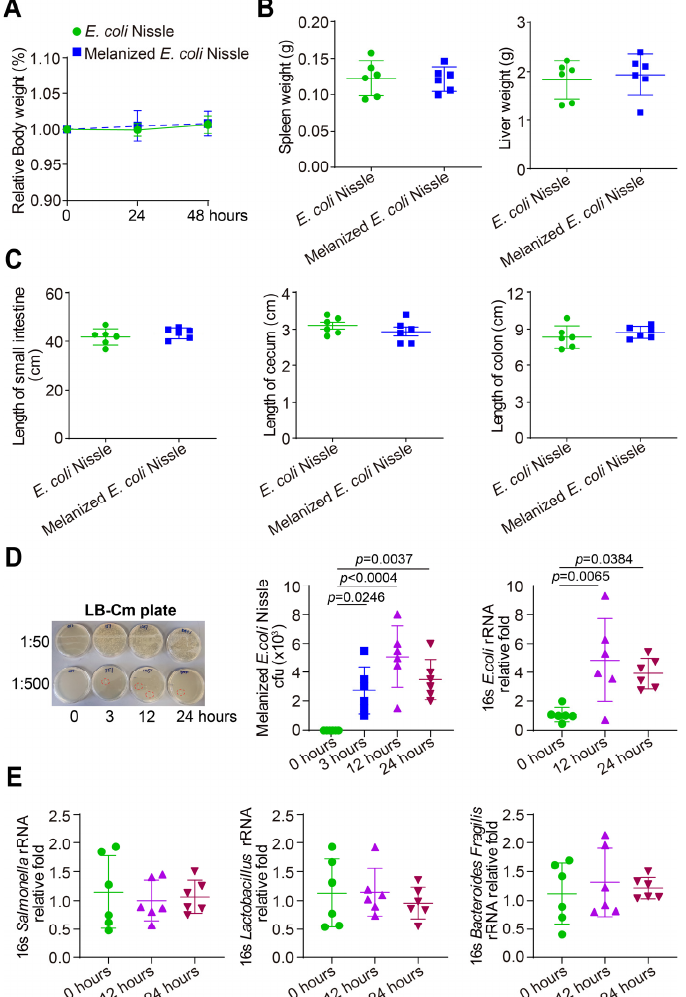
Figure 2. CD-1 mice were one-gavaged with probiotic E. coli Nissle or melanized E. coli Nissle. ( A ) Relative body weight did not change in CD-1 mice gavaged with probiotic E. coli Nissle or melanized E. coli Nissle. Data are expressed as mean ± SD. N = 6, two-way ANOVA test and the p -values were adjusted with Tukey method for multiple comparisons. ( B ) The spleen and liver weight did not change significantly in CD-1 mice gavaged with probiotic E. coli Nissle or melanized E. coli Nissle post 48 h. Data are expressed as mean ± SD. N = 6, Welch’s t test. ( C ) The length of small intestine, cecum and colon did not change in CD-1 mice gavaged with probiotic E. coli Nissle or melanized E. coli Nissle post 48 h. Data are expressed as mean ± SD. N = 6, Welch’s t test. ( D ) The melanized E. coli Nissle in feces post one-gavage was tested by culture and PCR. The melanized E. coli Nissle (LB cm agar plates, 10 µ g/mL) was cultured using one-gavaged mice fecal samples. The melanized bacteria could be detected at 3, 12, and 24 h post treatment. The number of melanized bacteria increased at 3, 12, and 24 h post treatment compared to the before treatment in CFU count. The E. coli 16S rRNA RT-PCR amplification indicates the increased E. coli and melanized E. coli Nissle in fecal samples. Data are expressed as mean ± SD, N = 6, one-way ANOVA test and the p -values were adjusted with Tukey method for multiple comparisons. All p values are shown in this figure. ( E ) The compositions of Salmonella , Lactobacillus and Bacteroides Fragilis did not change in the melanized bacteria-treated mice. Data are expressed as mean ± SD. N = 6, one-way ANOVA test and the p -values were adjusted with Tukey method for multiple